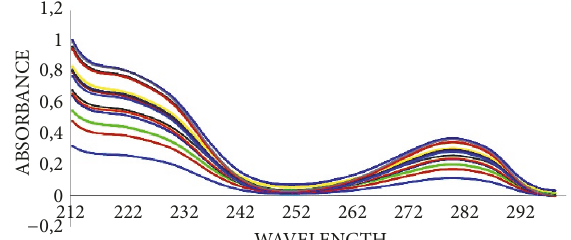
the number of new components (PC) created. The PLS and PCR were applied, providing precision, accuracy, and selectivity in the results.